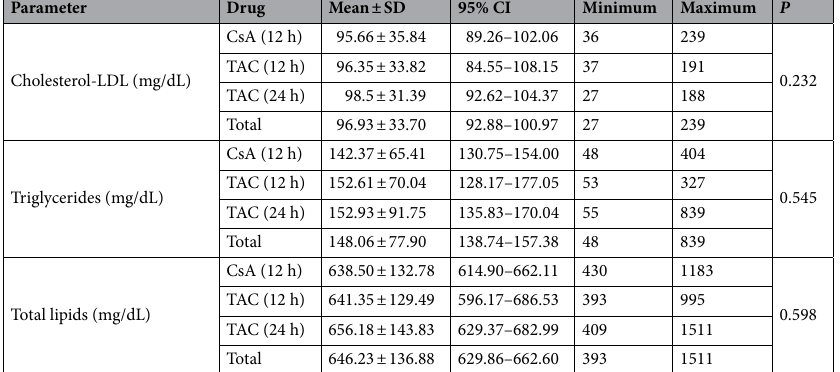
Table 1. Clinical and biochemical parameters in renal transplant patients receiving cyclosporine A (CsA) or tacrolimus (TAC) every 12 or 24 h. The post-transplant follow-up period was between the third and sixth month after kidney transplantation. (CsA-12 h, n = 183), (TAC-12 h, n = 53), (TAC-24 h, n = 156). Values normally distributed are expressed as means ± standard deviation (SD). P-significance level for the difference between the groups (one-way ANOVA). BMI body mass index, ALT alanine transaminase, AST aspartate transaminase, eGFR estimated glomerular filtration rate.